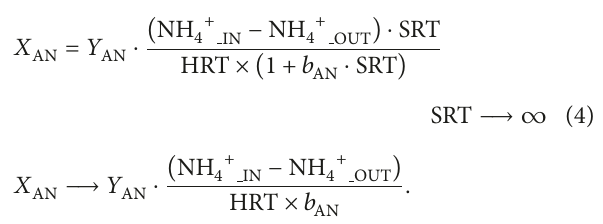
Oct, Nov, Dec, and Jan were 0.82, 0.77, 0.64, and 0.48 gVSS/L, respectively. Under the aerobic condition, the VSS in Oct did not change significantly, and was 1.03 gVSS/L. Nevertheless, the color changed significantly and turned light grey, which indirectly indicates the reduction of microbial activity. The VSS in Nov declined severely from the previous month and was 0.38 gVSS/L. The VSSs in Dec and Jan were 0.23 and 0.24 gVSS/L, respectively, indicating the microbes almost all decayed in the third and fourth months.